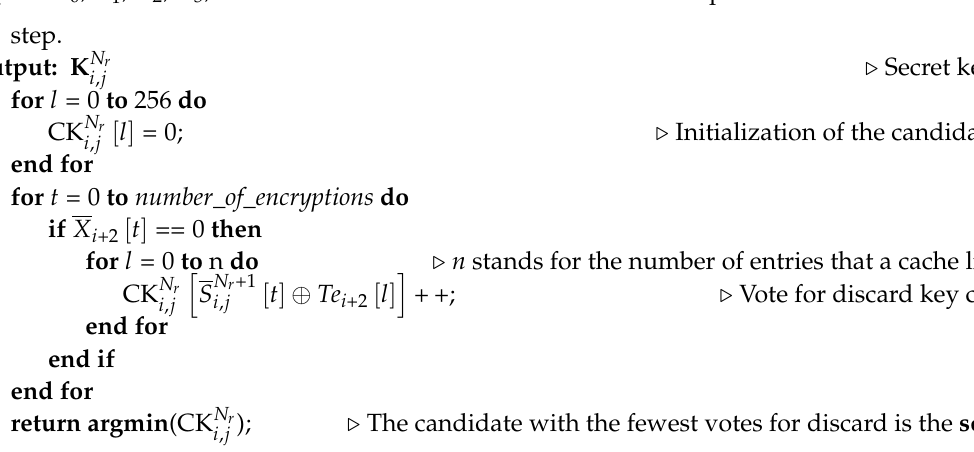
Algorithm 2 Recovery algorithm for key byte K N r